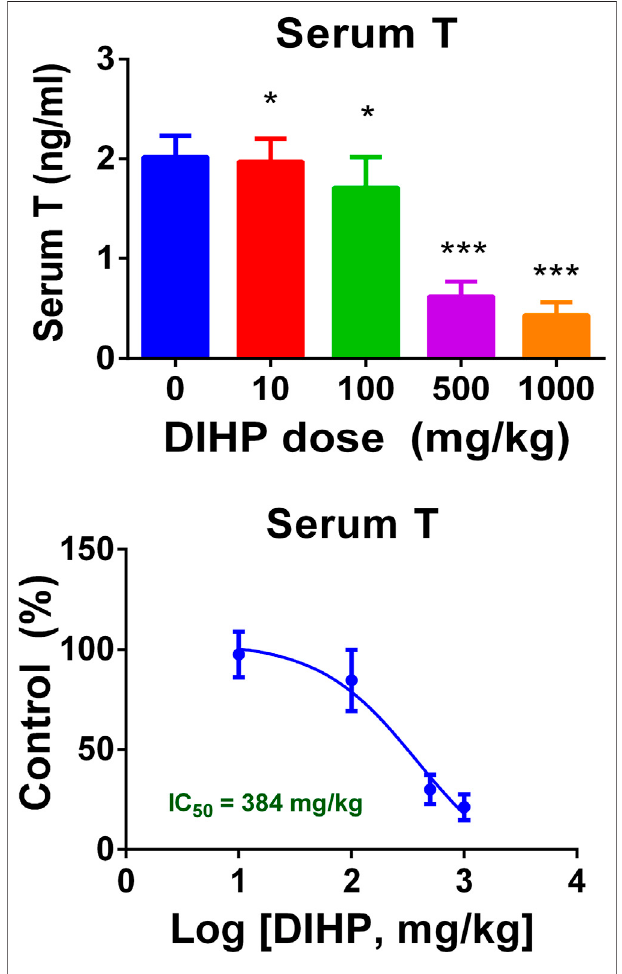
FIGURE 3 | Effect of DIHP exposure during pregnancy on serum testosterone (T) levels. From GD12 to GD21, the dams were gavaged with 0 (control), 10, 100, 500, and 1,000 mg/kg DIHP. (A) Serum T level; (B) IC 50 value of DIHP; data expressed as mean ± SEM, n (cid:1) 6; * p > 0.05, *** p < 0.01 indicate that the signi fi cant level between the DIHP group and the control group,